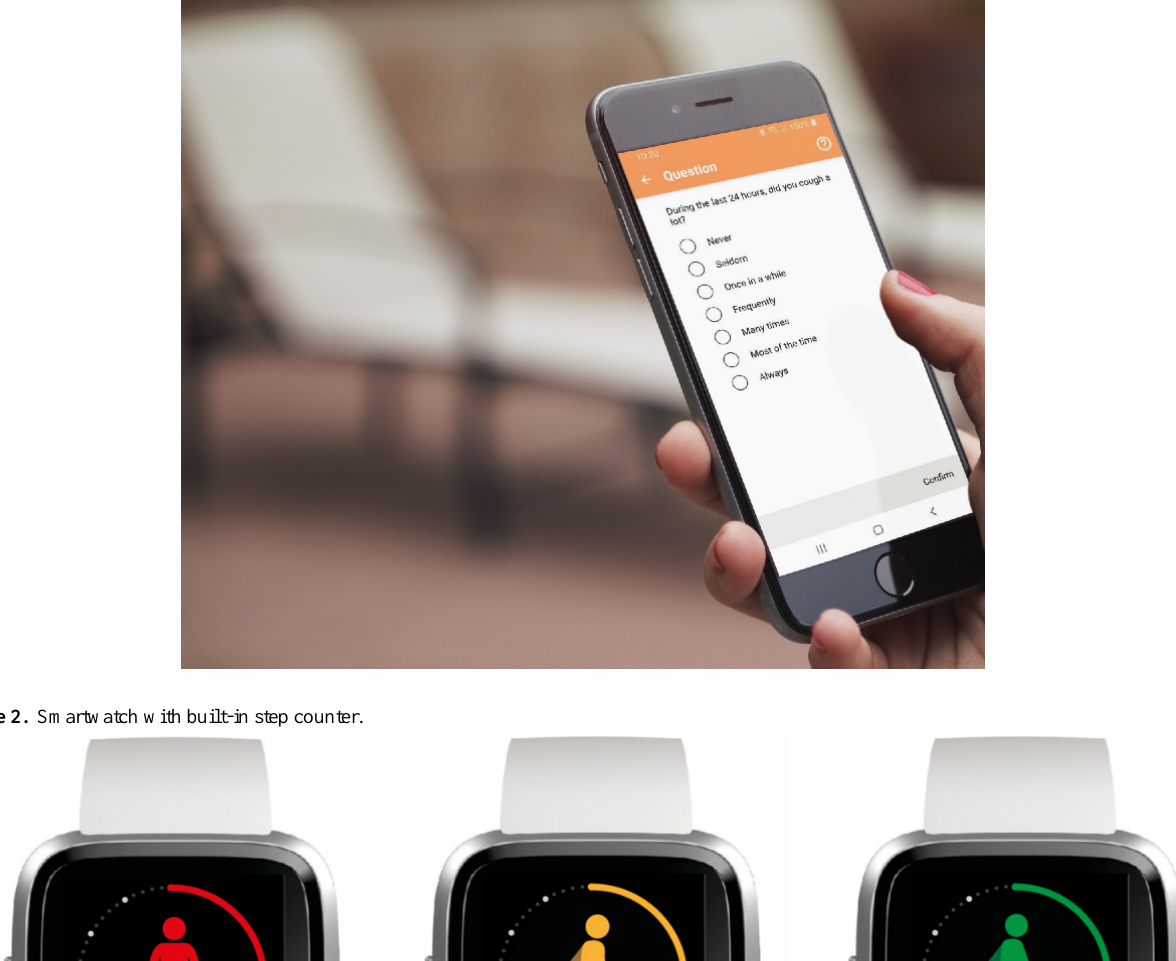
Figure 1. Questionnaire app to monitor symptoms.